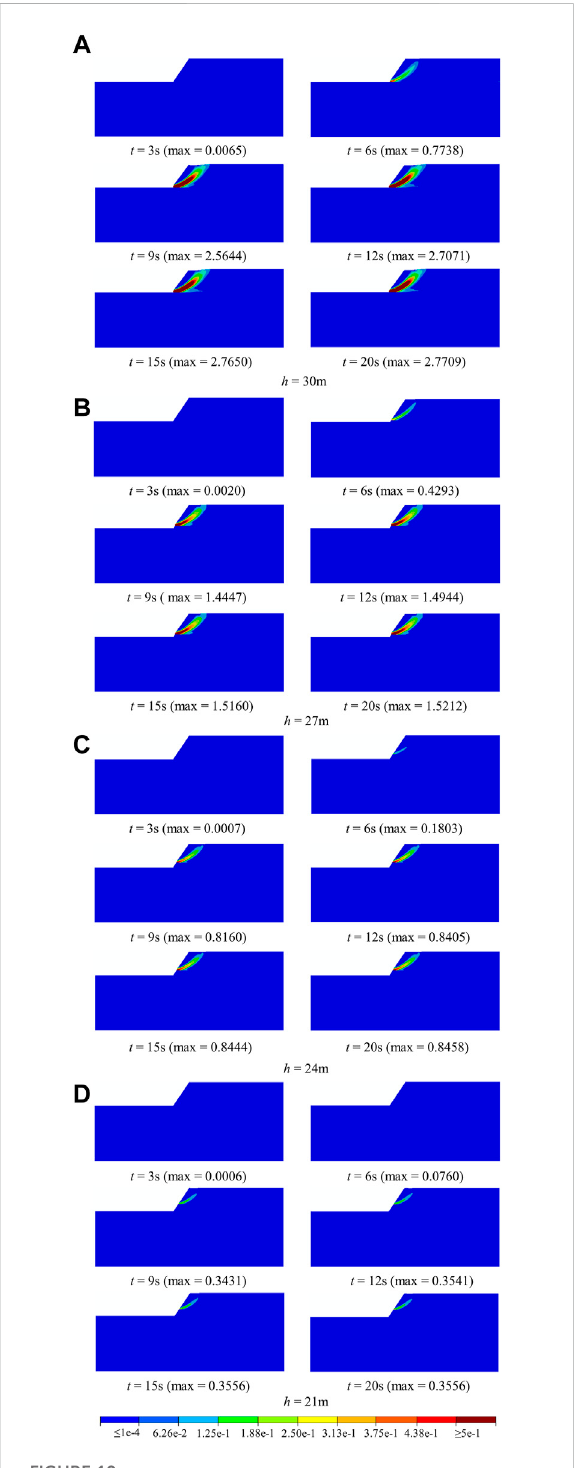
FIGURE 10 Plastic strain nephograms of the slope at different timings with different soft – hard rock interface positions. (A) h = 30 m. (B) h = 27 m. (C) h = 24 m. (D) h = 21